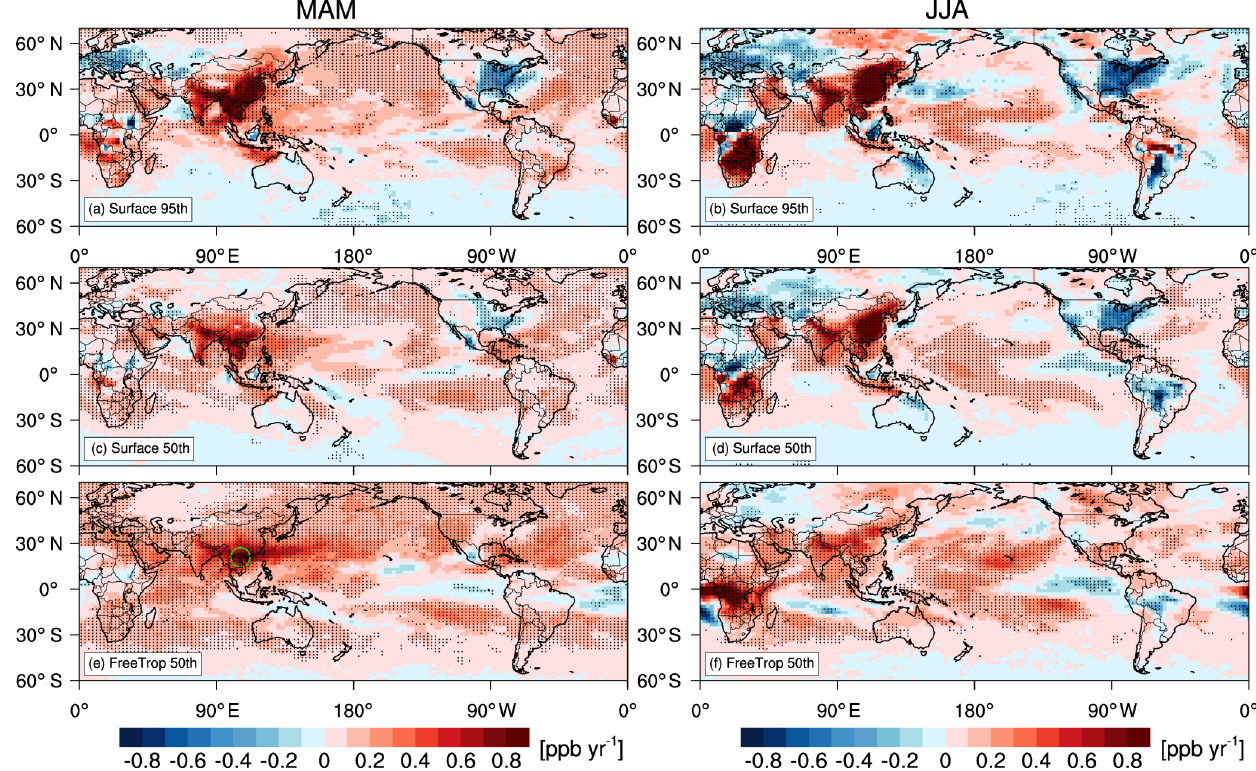
Figure 4. Global distribution of MDA8 O 3 trends from AM3 BASE over 1988–2014 for boreal spring (left) and summer (right) for the 95th percentile at the surface (a–b) , median at the surface (c–d) , and median in the free troposphere (700hPa; e–f ). Stippling indicates areas where the trend is statistically significant ( p <0.05). The color scale is designed to resolve regional features rather than extreme values and saturates. The range of the trends is − 1 to + 2.5ppbyr − 1